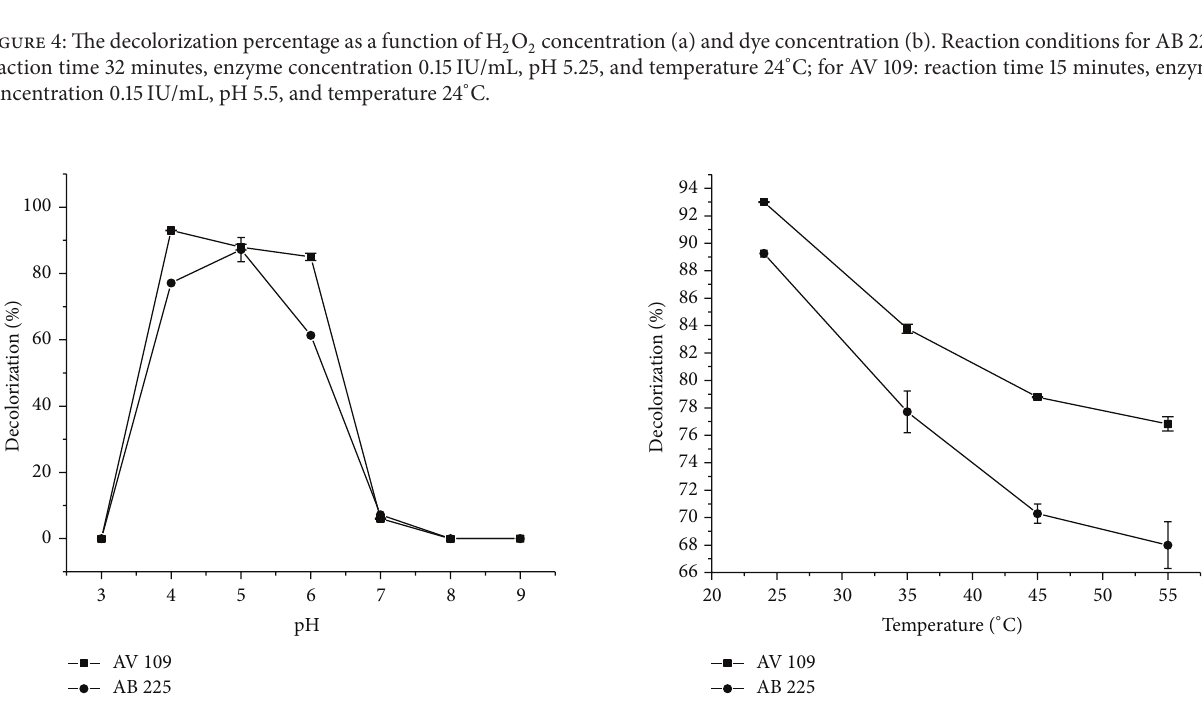
Figure 5: The influence of the initial pH on AB 225 and AV 109 decolorization at 24 ∘ C with 0.15 IU/mL HRP. Reaction conditions for AB 225: 32 minutes, dye concentration 30 mg/L, and hydrogen peroxide concentration 0.04 mM; for AV 109: 15 minutes, dye con- centration 30 mg/L, and hydrogen peroxide concentration 0.4 mM. Relative standard deviations (RSD) of triplicate measurements were always less than 5%.